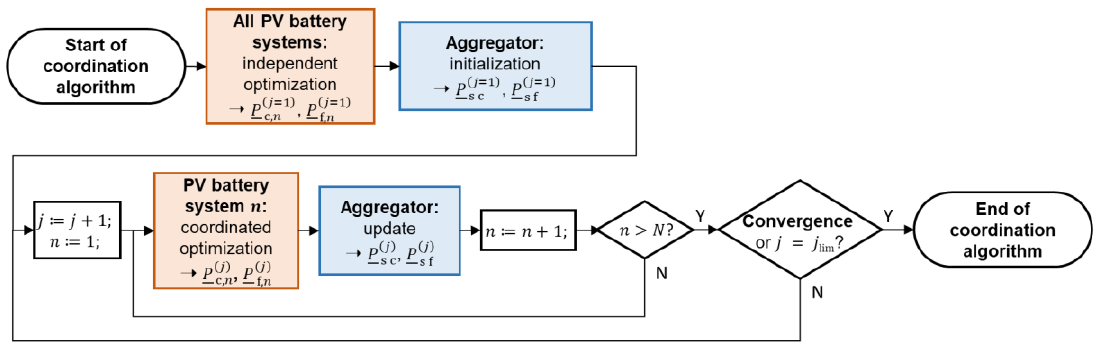
Figure 8. Program flow chart of the coordination algorithm.